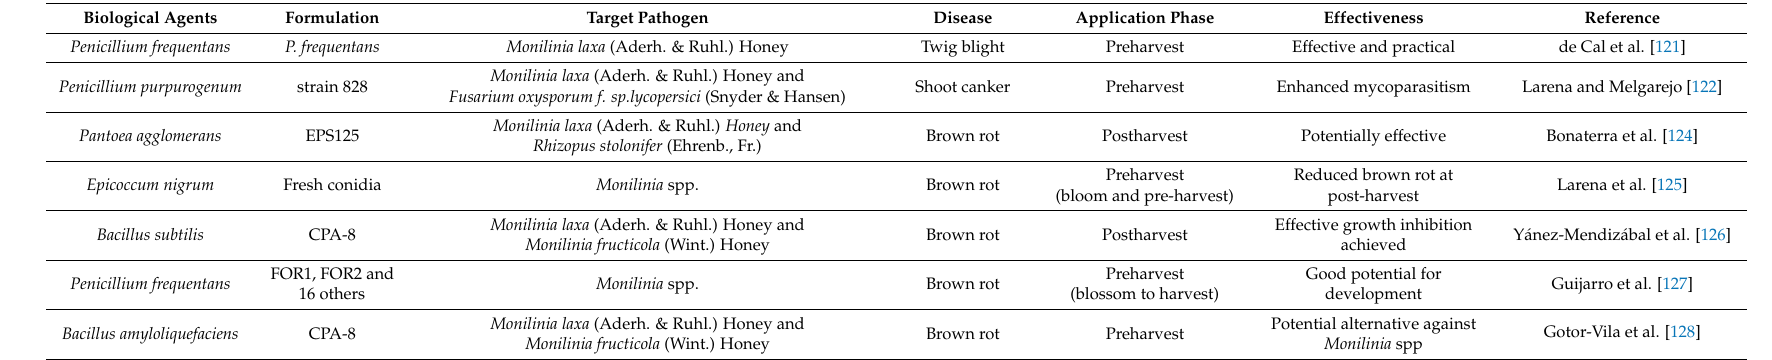
Table 3. Biological control agents (BCAs) against Monilinia spp. in